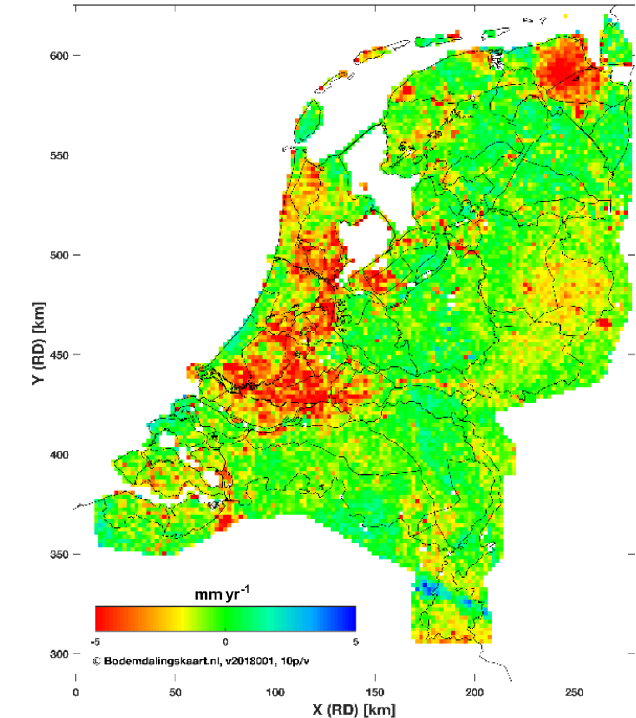
Figure 1. Subsidence map of the Netherlands (© Bodemdal- ingskaart.nl,